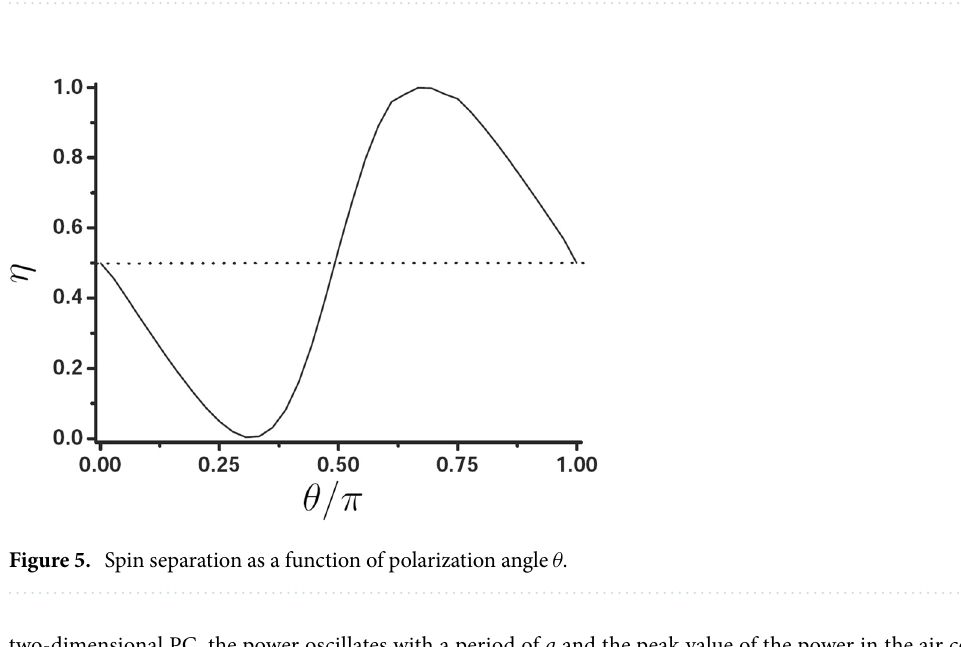
Figure 4. Variation of average spin ¯ s with x .